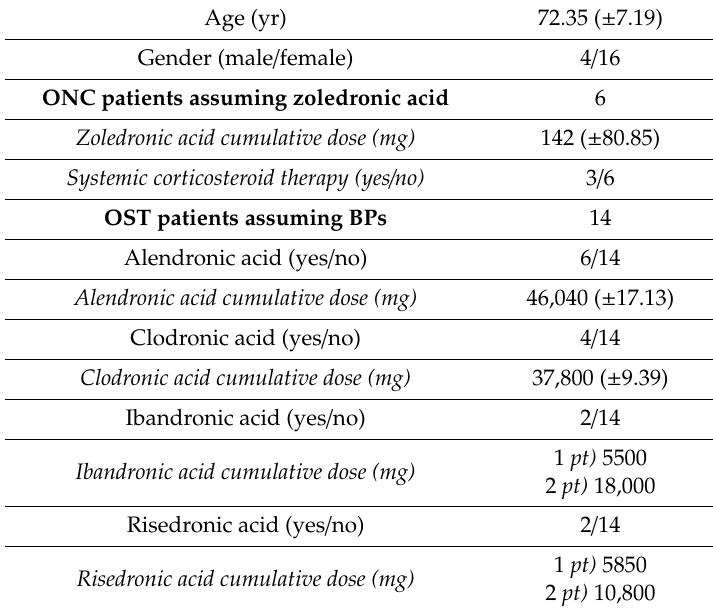
Table 3. Descriptive details of patients enrolled (n = 20; ONC = 6; OST = 14).